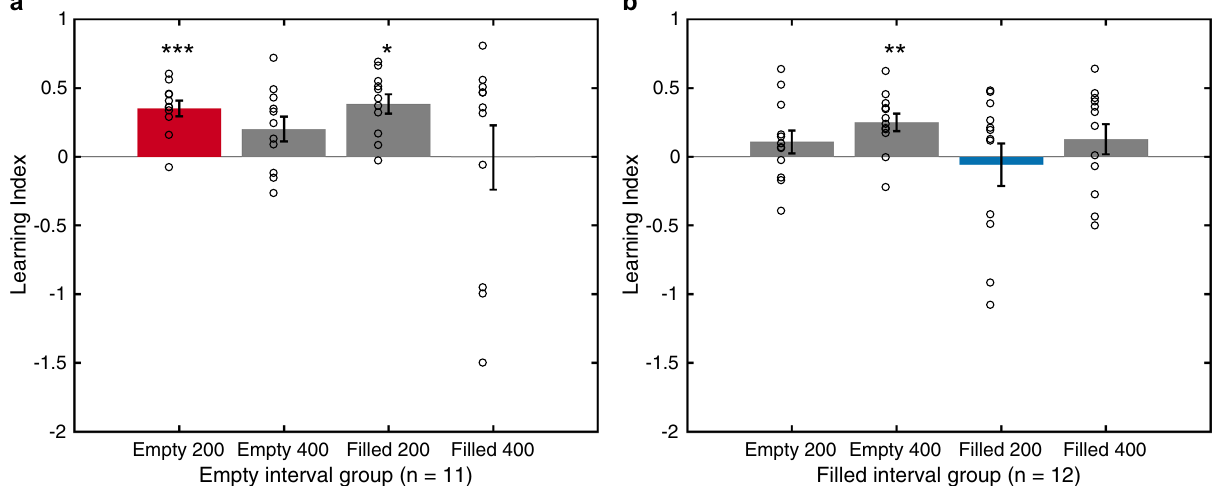
Figure 4. The transfer effects of four conditions for the empty-interval (EI) group ( a ) and the filled-interval (FI) group ( b ). The learning index (LI) is defined as the percentage change in the pre-test threshold (i.e. (pre–post)/ pre threshold). A positive LI value indicates improvement after training. The red and blue bars indicate the trained condition for each group whereas the other three grey bars represent the untrained conditions. Dots signify individual learning indices. Error bars specify between-subject standard errors (s.e.m.). The asterisks on each bar denote significant results from one-sided, one-sample t-tests with Bonferroni corrections. * p < .05, ** p < 0.01, *** p <